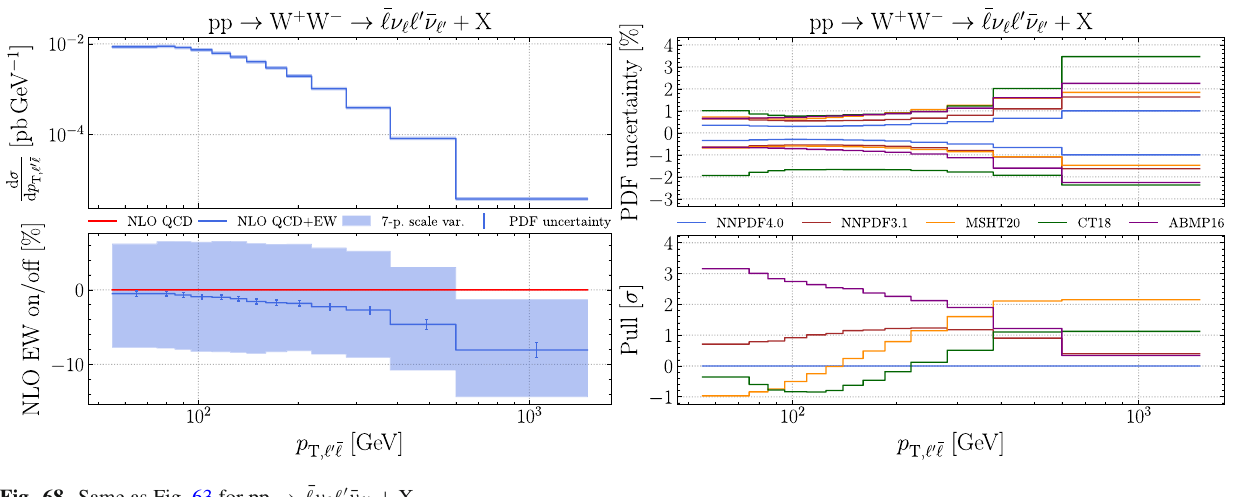
Fig. 68 Same as Fig. 63 for pp → ¯ (cid:5)ν (cid:5) (cid:5) (cid:8) ¯ ν (cid:5) (cid:8) + X